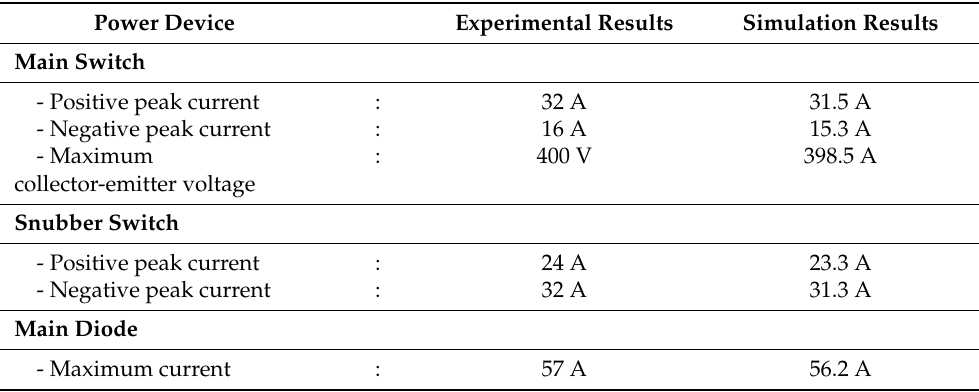
Figure 16. Output voltage V o (blue-Scale: 150 V / div) and output current I o (purple-Scale: 5 A / div). Total time: 10ms.